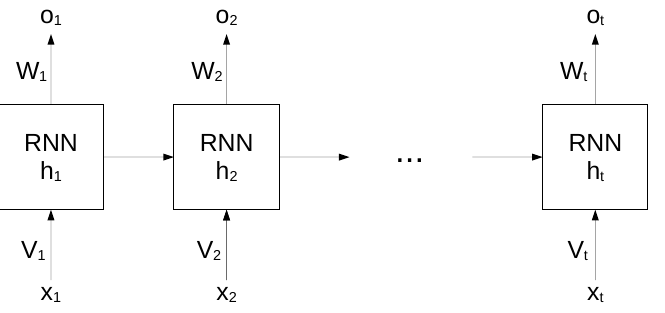
Figure 1. Structure of an RNN.